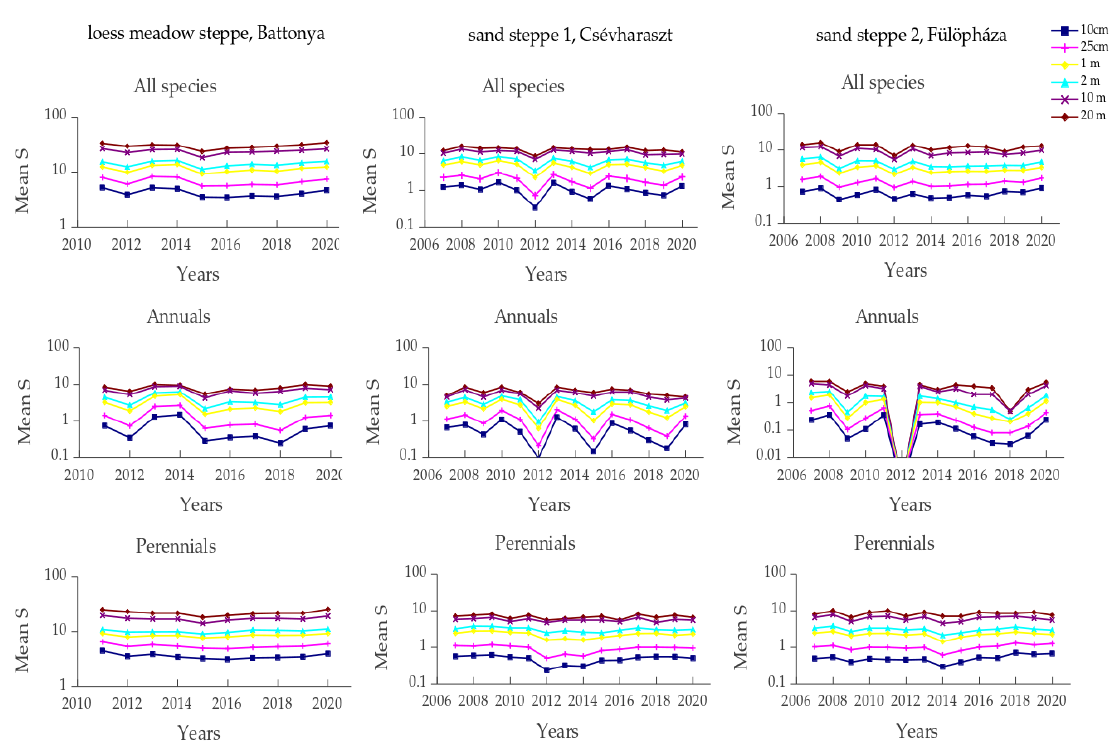
Figure 4. Temporal patterns of species richness observed at six spatial scales. Community-level patterns (all species) and species richness of functional types (annuals and perennials) are printed separately at each site.